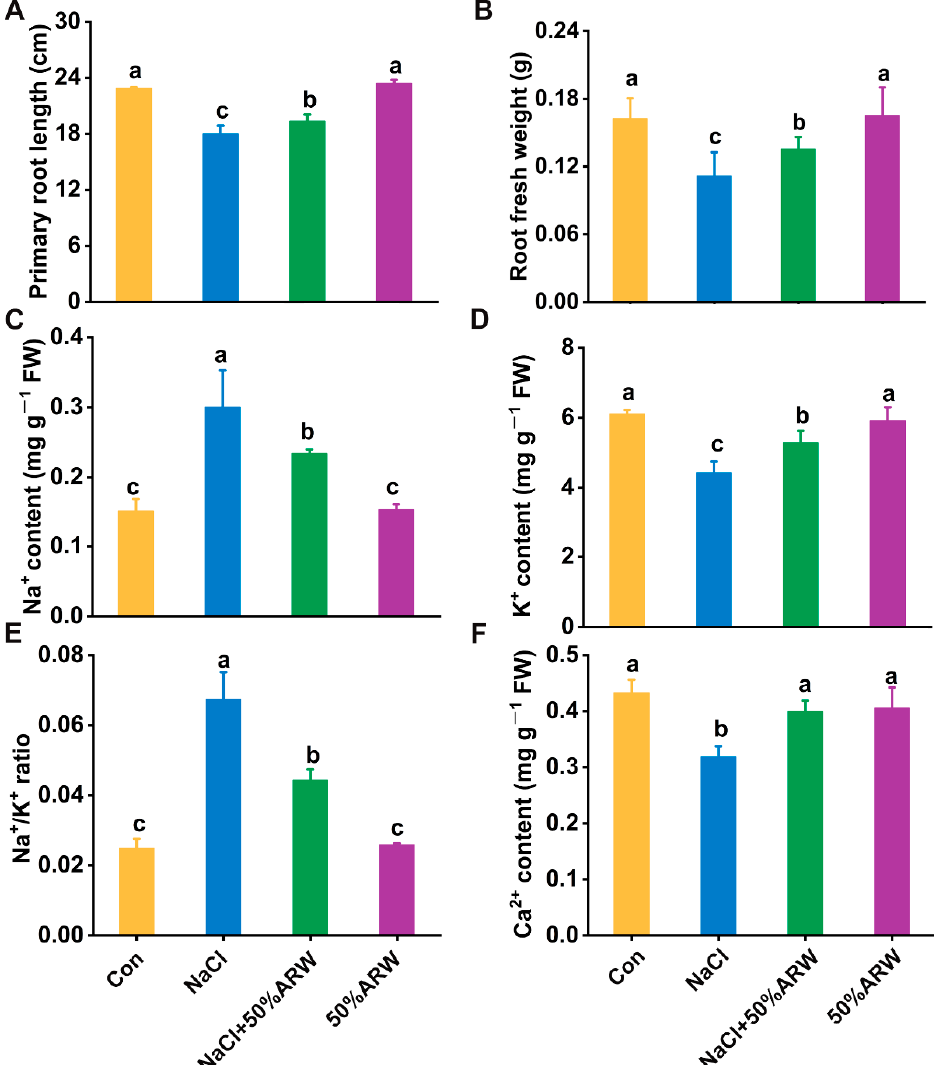
Figure 7. Inhibition of alfalfa growth and ion imbalance caused by NaCl stress were improved by argon. After 21 days of the pot treatment, the root length ( A ) and fresh weight ( B ) were measured ( n = 3; 27 samples/treatment/repeat). Additionally, the Na + ( C ) and K + ( D ) contents in the root tissue, as well as the Na + /K + ratio ( E ) and the Ca 2+ contents ( F ), were determined and calculated. The error bars represent the SD. Bars with different letters were significantly different at p < 0.05 according to Duncan’s multiple range test.